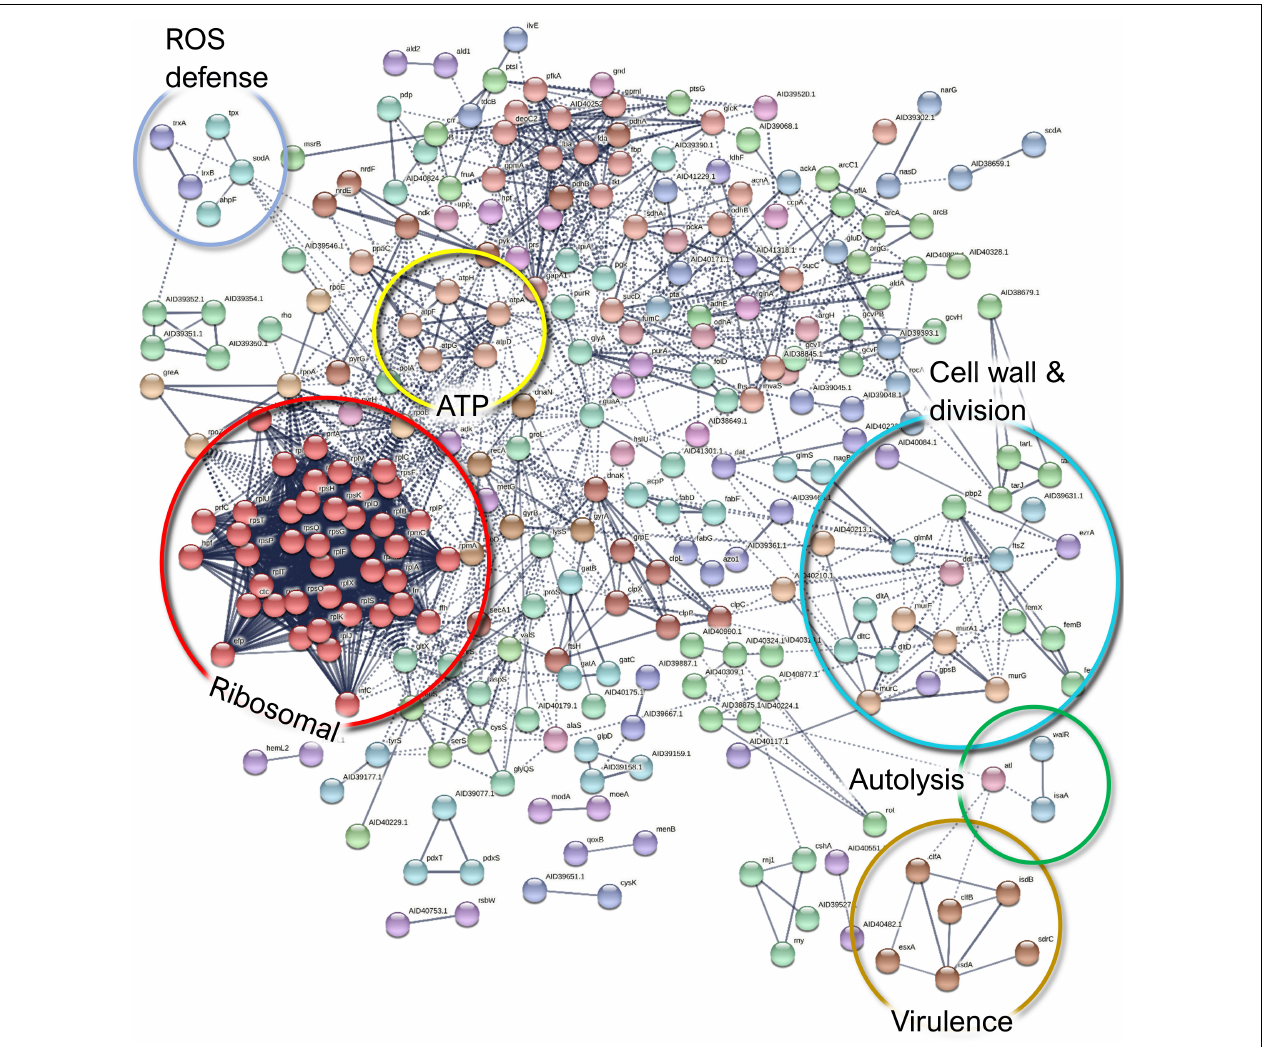
FIGURE 10 | A STRING database (Szklarczyk et al., 2019) network of interacting proteins with a significantly lower abundance in Staphylococcus aureus co-culture versus monoculture